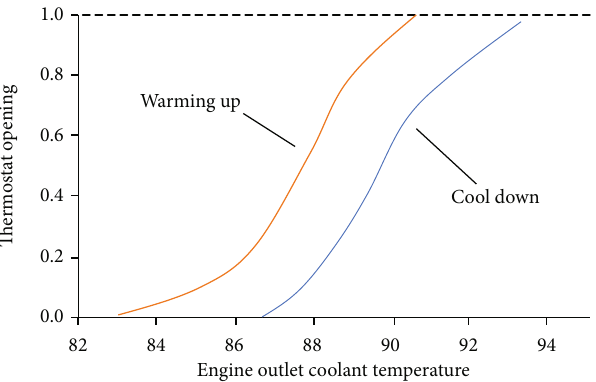
Figure 3: Thermostat opening temperature characteristic